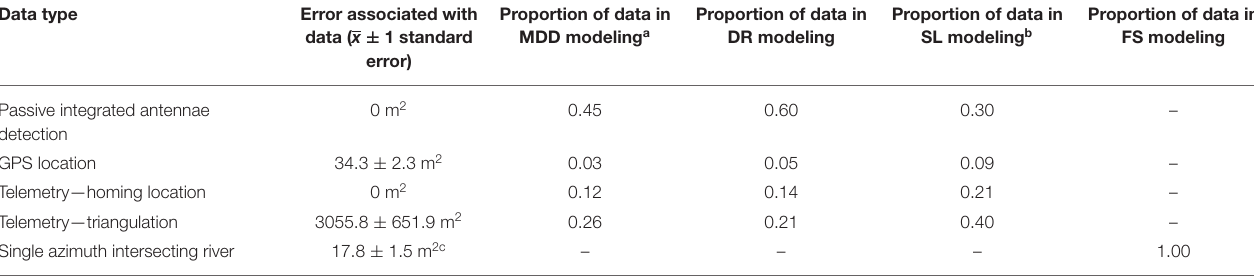
TABLE 1 | Types of location data used in models of beaver movement, collected from May 2019 to March 2021 in desert rivers in east-central Utah, USA. Data